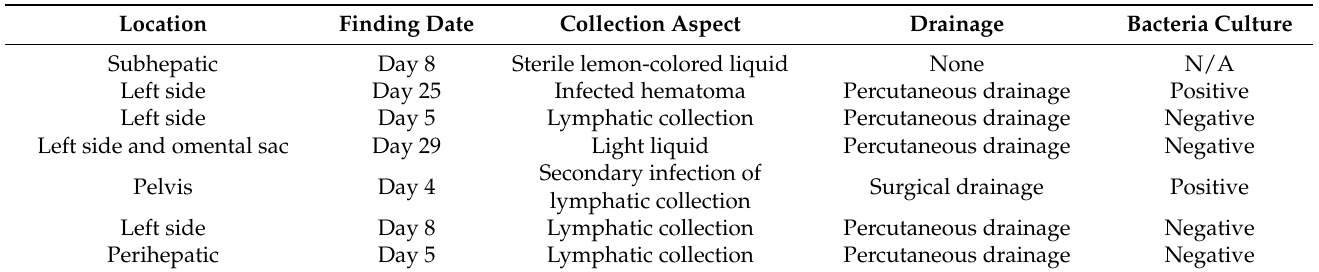
Table 2. Characteristics of intra-abdominal